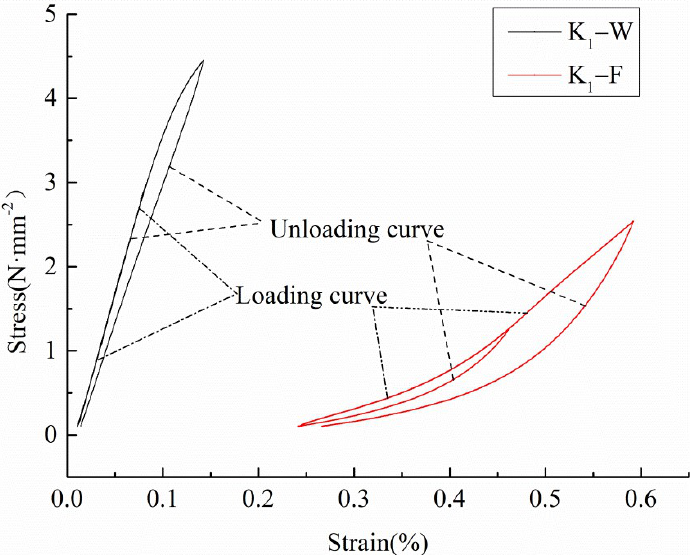
Figure 6. Second and third level stress–strain curves of the tested K 1 samples.